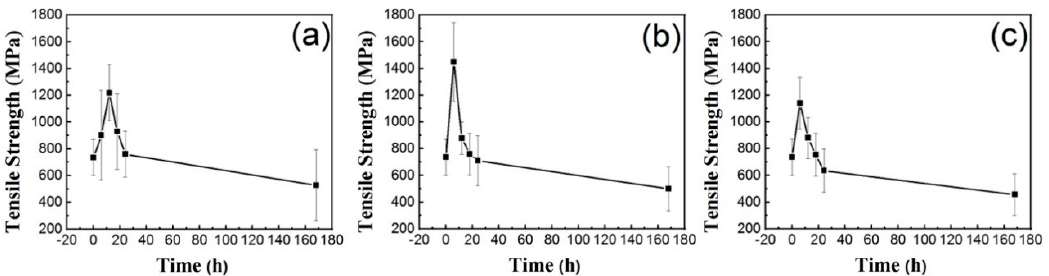
Figure 2. The tensile strength of basalt fiber immersed in seawater solution at different temperatures ( a ) 80 °C; ( b ) 85 °C; ( c ) 90 °C.